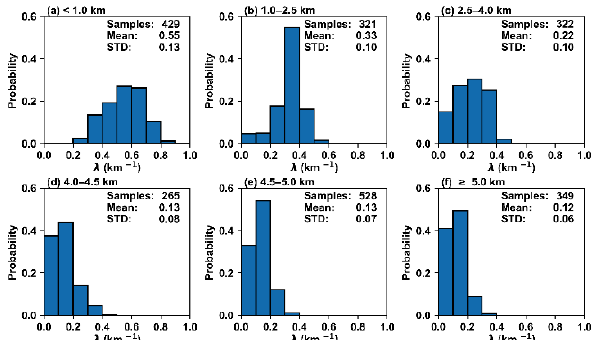
Figure 3. The probability density distributions of entrainment rate ( λ ; units: km − 1 ) in the different terrain height ranges in the boreal summer from 2013 to 2017; the sample number (Samples), mean value (Mean), and standard deviation (STD) are shown in the panels.